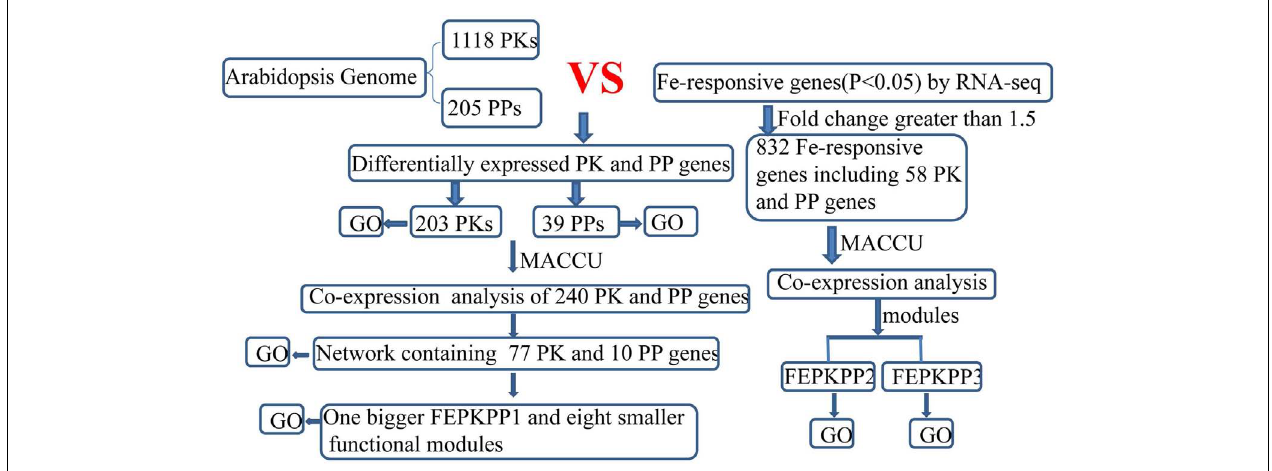
FIGURE 1 | Flowchart for mining differentially expressed PK and PP genes and subsequent co-expression analysis in Arabidopsis iron-deficient roots .